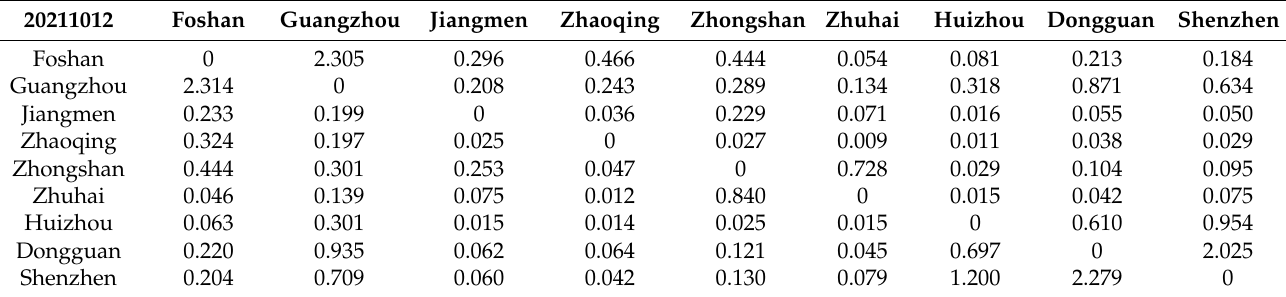
Table 3. Results of constructing daily intercity mobility OD matrix on 12 October